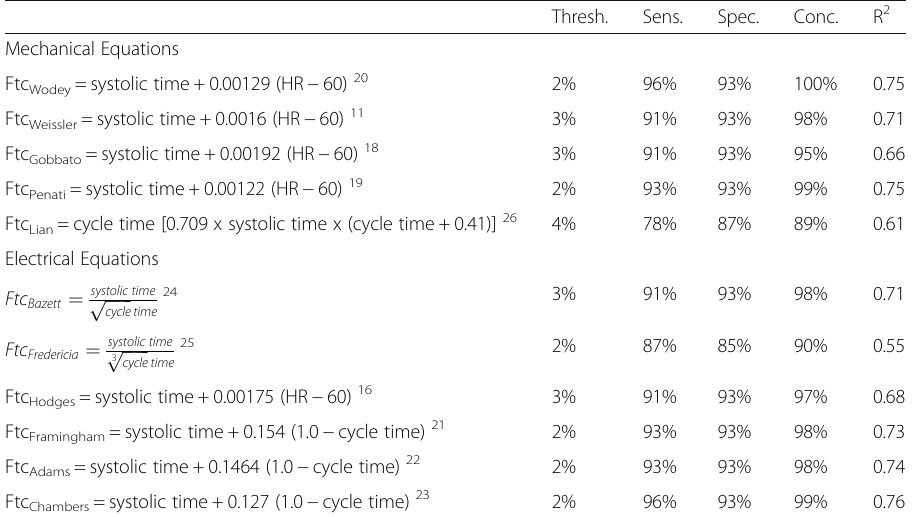
Table 1 Diagnostic characteristics of 11 Ftc formulae